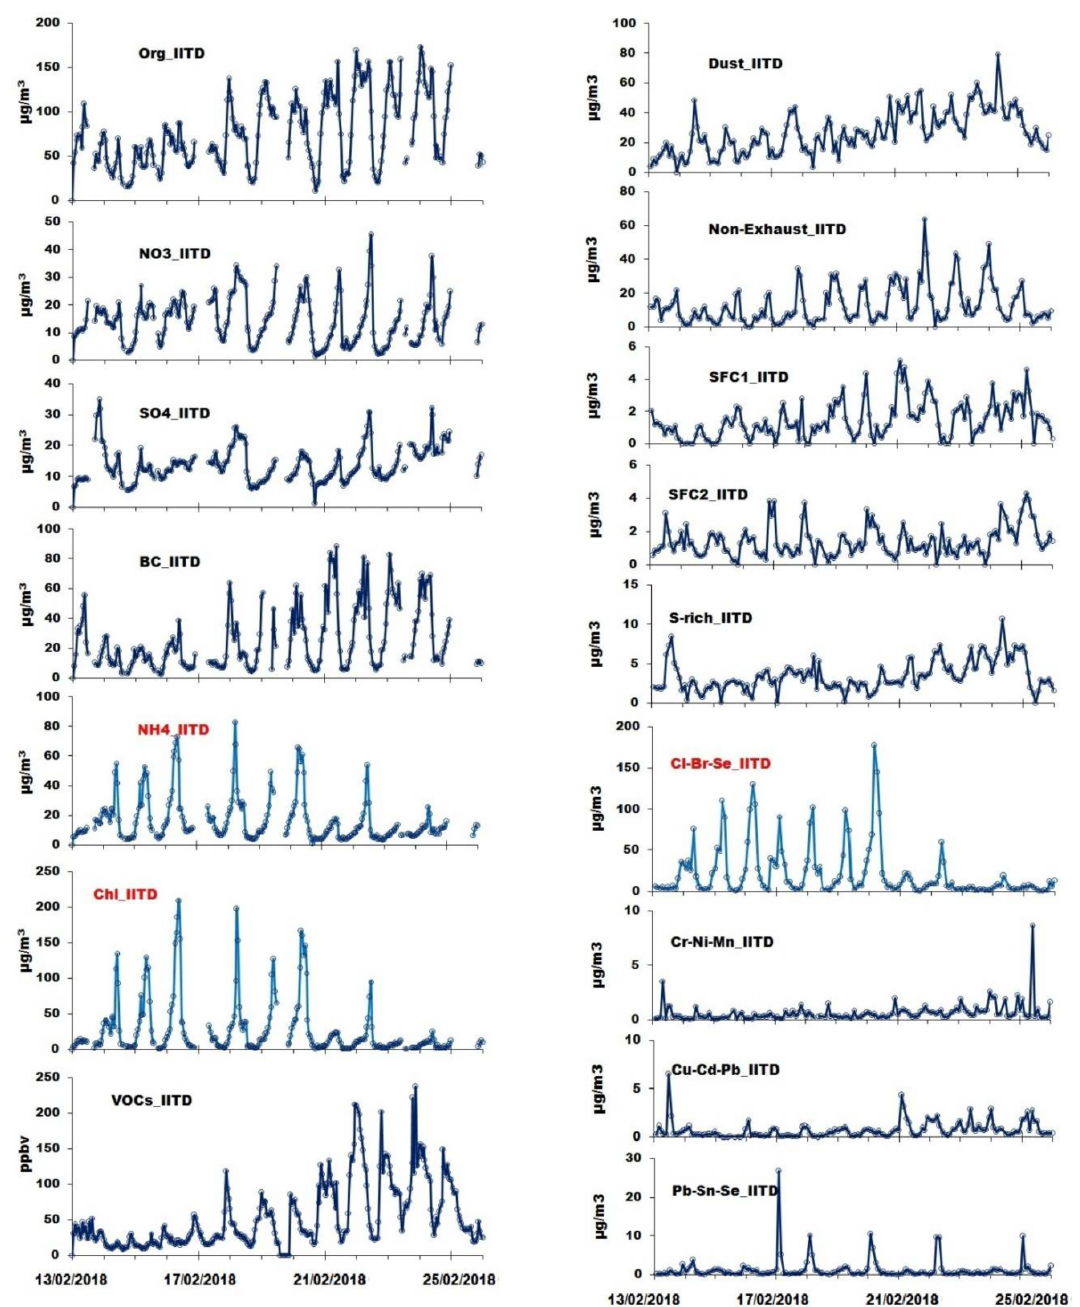
Figure 5. Time series of particulate OA, NO3, BC, SO4, NH4, Chl, gaseous VOCs, and nine factors of elements (dust, nonexhaust, SFC1, SFC2, S-rich, Cr-Ni-Mn, Cl-Br-Se, Cu-Cd-Pb, and Pb-Sn-Se) during 13–26 February 2018 at the IITDelhi